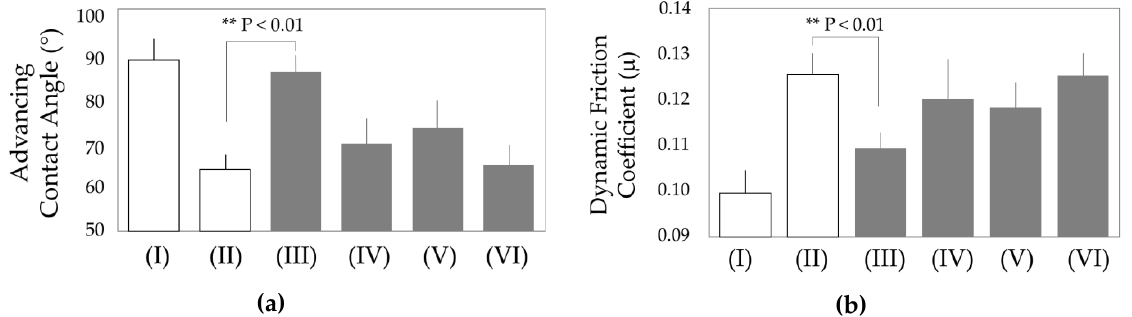
Figure 4. ( a ) Advancing contact angle of each hair samples (N = 7 for each). (I) Untreated Hair. (II) Bleached and weathered hair. (III) Bleached and weathered hair treated with 18-MEA/SPDA containing conditioner. (IV) Bleached and weathered hair treated with conditioner containing 18-MEA/DAPS (Dimethylaminopropylstearamide). (V) Bleached and weathered hair treated with conditioner containing 18-MEA/STAC (Stearyltrimethylammonium Chrolide). (VI) Bleached and weathered hair treated with control conditioner. ( b ) Dynamic friction coefficient of each hair samples (N = 5 for each). Table 4. Formulations of the conditioners (wt %).